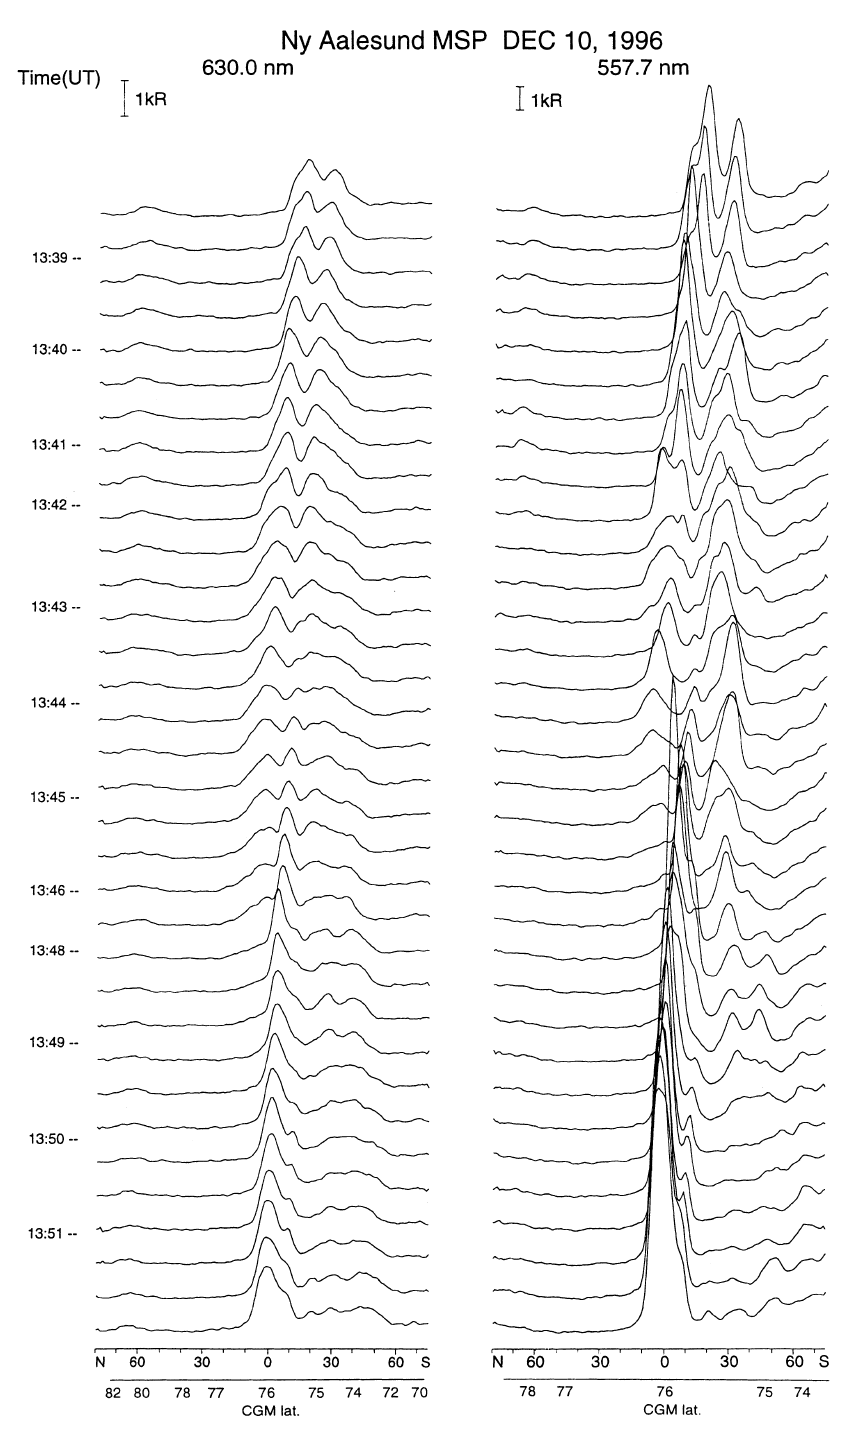
Fig. 4. The image has been plotted over the latitudinal range 75 (cid:176) to 80 (cid:176) N to illustrate the main features of the polar ionosphere at this time. The dominant structures are an intense region of auroral-E ionisation around